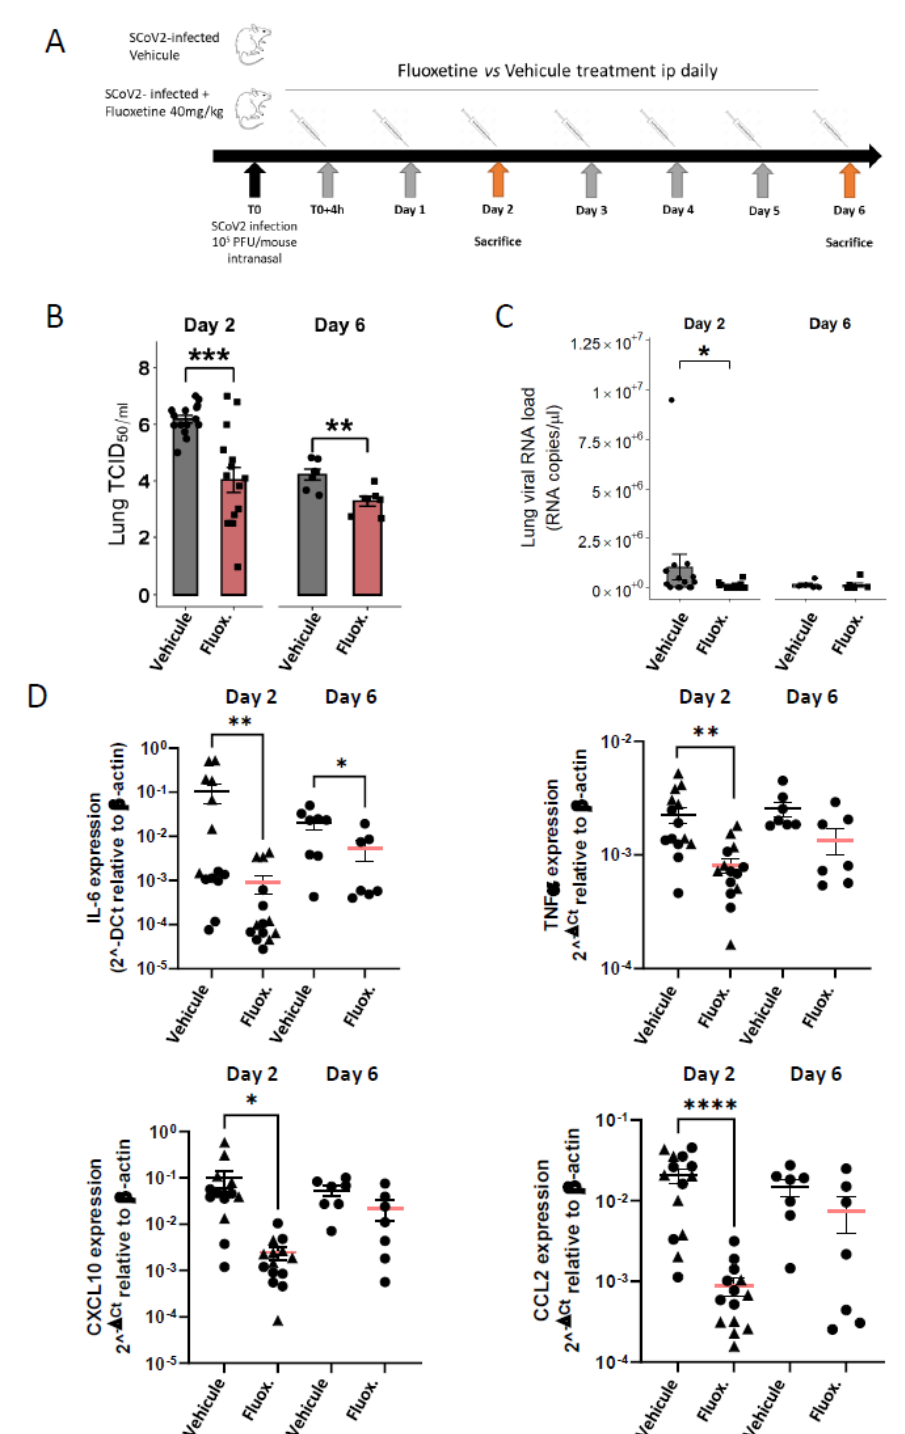
Figure 1. Fluoxetine reduced viral load and inflammatory response in K18-hACE2 mice infected with SARS-CoV-2. ( A ) Experimental design of the study; ( B ) infectious viral loads in the lungs of vehicle- and fluoxetine-treated mice infected with SARS-CoV-2 at day 2 and 6 post-infection expressed as log10 TCID50/mL; ( C ) viral RNA levels in the lungs of vehicle- and fluoxetine-treated mice infected with SARS-CoV-2 at day 2 and 6 post-infection expressed as Lung SARS-CoV-2 RNA load (RNA copies/ µ L). ( D ) Cytokine and chemokine transcripts in lung tissue at day 2 and 6 post- infection of SARS-CoV-2-infected mice, treated with vehicle or with fluoxetine. *, p < 0.05; **, p < 0.01; ***, p < 0.001; ****, p <